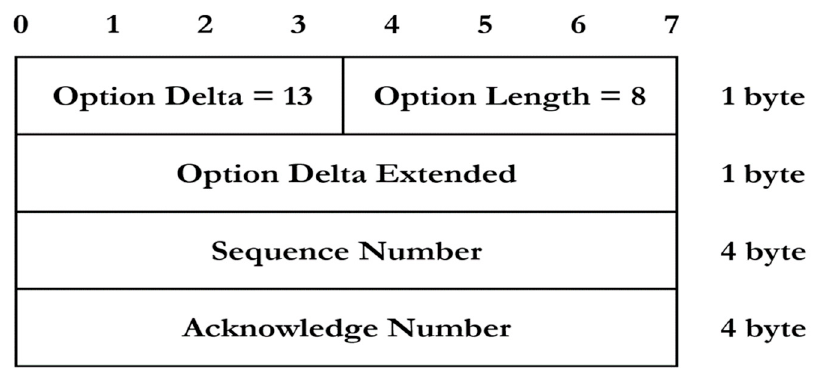
Figure 15. CoAP-SC option header format.